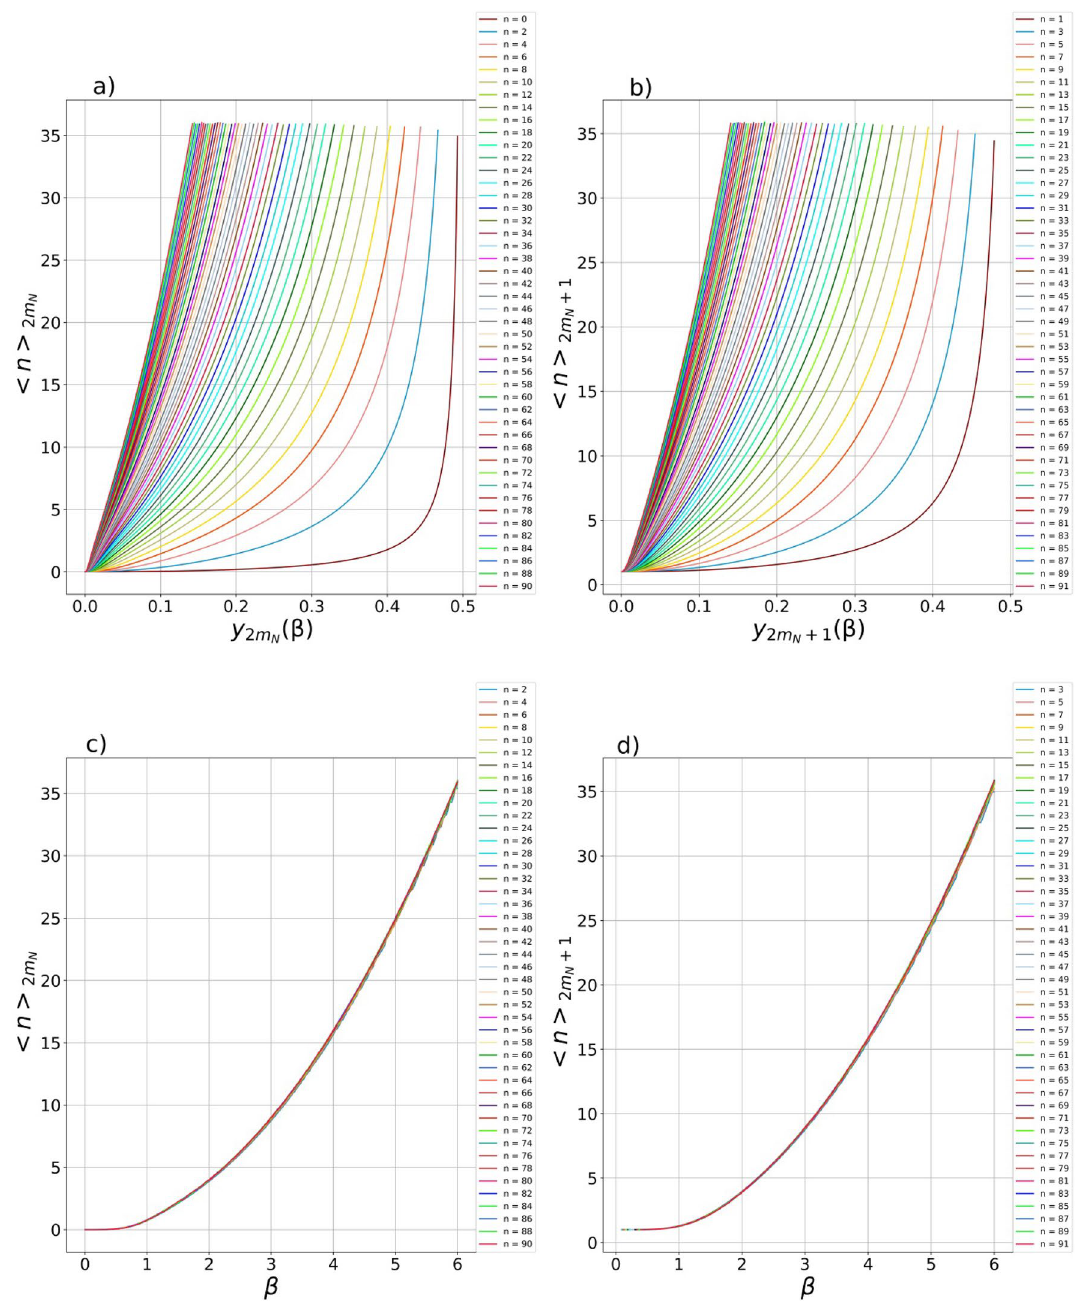
n n and ( b ) in generated CV states (cid:31) (cid:30) 2 m N � � 2 m N + 1 (β) and y 2 m (β) , respectively, which provide the maximum fidelity of the states with even/ N N + 1 n n and ( d ) depending on the corresponding SCS amplitude β , the (cid:31) (cid:30) 2 m N � � 2 m N + 1